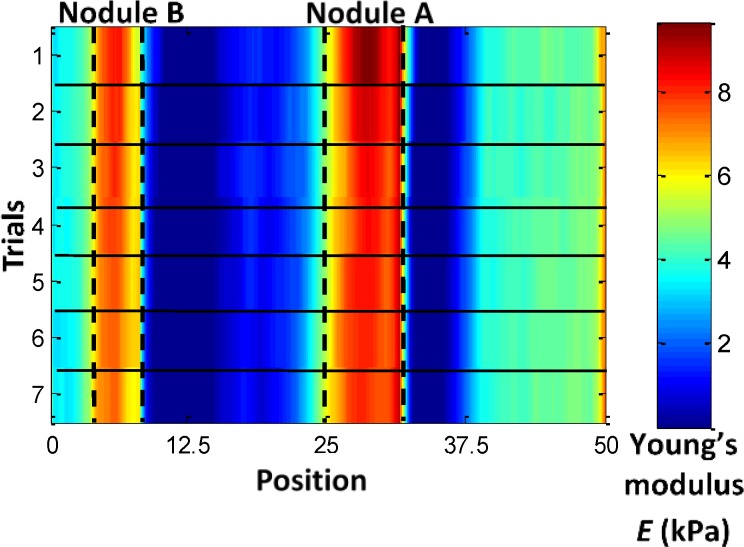
Stiffness map estimated from the perpendicular reaction force along the same trajectory in multiple trials of remote palpation with increased velocity from trials 1 to 7.Nodules A and B are presented in red or orange, whereas other areas are presented in blue or cyan.